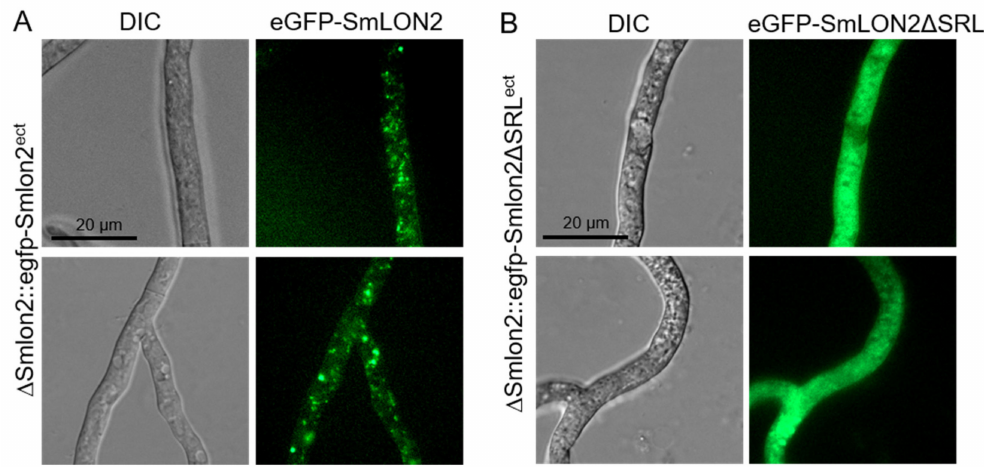
Figure 3. Localization of SmLON2 and SmLON2 ∆ SRL tagged with eGFP. ( A ) Fluorescence microscopy was performed with the deletion mutant ∆ Smlon2 carrying plasmid pegfp-Smlon2 and ( B ) plasmid pegfp-Smlon2 ∆ SRL, respectively. Scale bars are indicated. DIC, differential interference